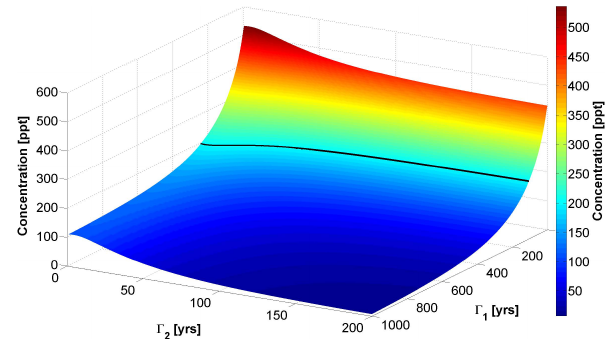
= 1 . 4, Figure 4. Example mean age matrix of CFC-12 with 1 1 / 0 1 1 2 / = 1 . 4 , ∆ 2 / Γ = 0 . 6 and α = 80 . The color-coding denotes the con- Fig. 4: Example mean age matrix of CFC-12 with ∆ 1 / Γ 0 2 = 0 . 6 and α = 80. The color-coding denotes the concentra- 1 2 centration of CFC-12 (in ppt, also on the Z-axis) with a black concentration contour line at 200 ppt; X and Y axis denotes the tion of CFC-12 (in ppt, also on the z axis) with a black concentra- mean age of the 2IG distributions that make up the TTD. The combination of all three dimensional tracer matrices provides the tion contour line at 200ppt; x and y axis denotes the mean age of needed information to constrain a 2IG-TTD, see text. the 2IG distributions that make up the TTD. The combination of all three-dimensional tracer matrices provides the needed information to constrain a 2IG-TTD, see